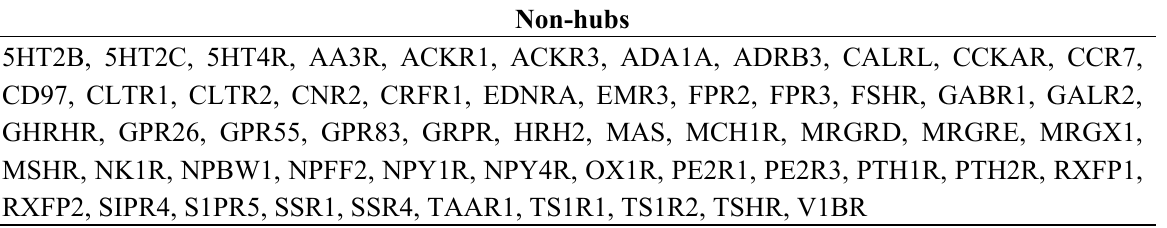
Table 5. Chosen non-hubs and